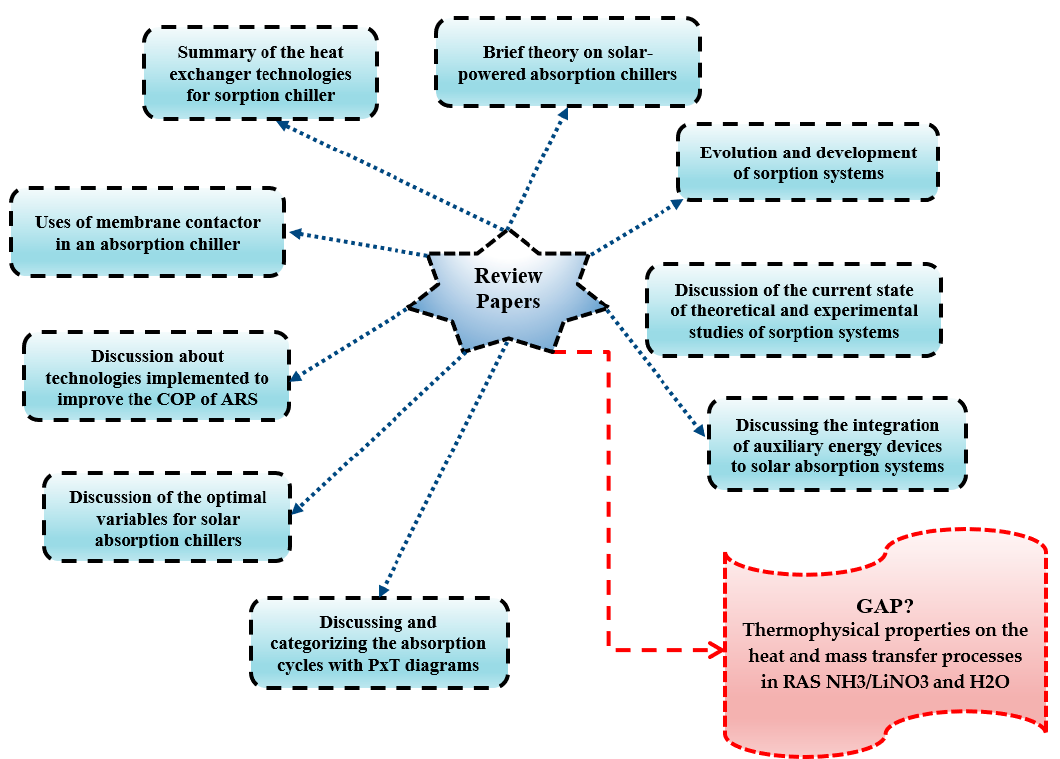
Figure 1. Review papers on the absorption chillers in the last 10 years and the gap found.